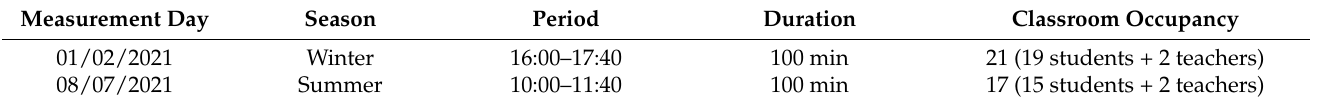
Table 1. Field monitoring experimental data obtained in the selected